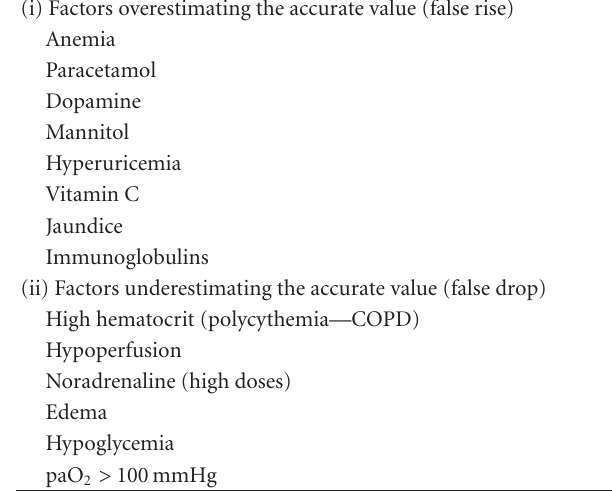
Table 6: Capillary glucose monitoring with test strips: factors interfering with correct